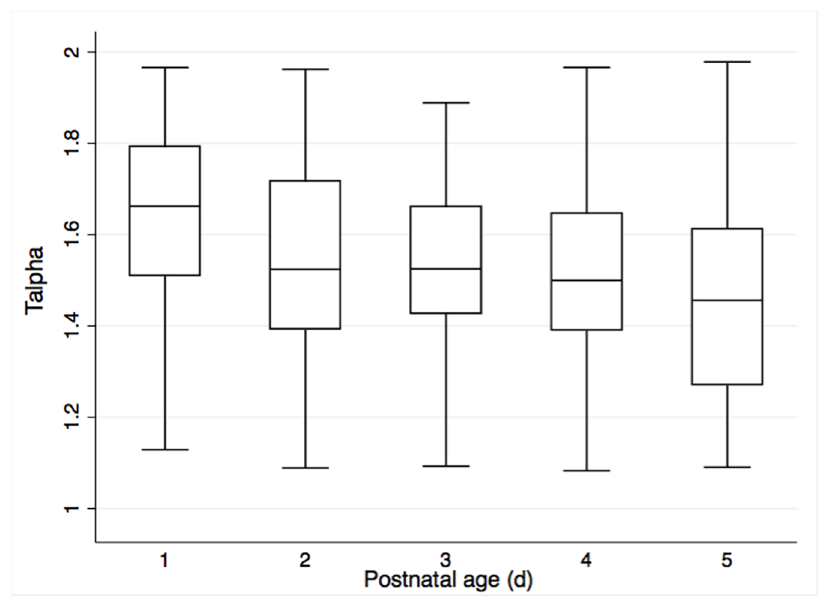
Fig 4. Scaling exponent alpha (T alpha ) over postnatal age. T alpha decreased from a mean (SD) of 1.67 (0.18) on day one of life to 1.46 (0.22) on day five of life (p < 0.001).